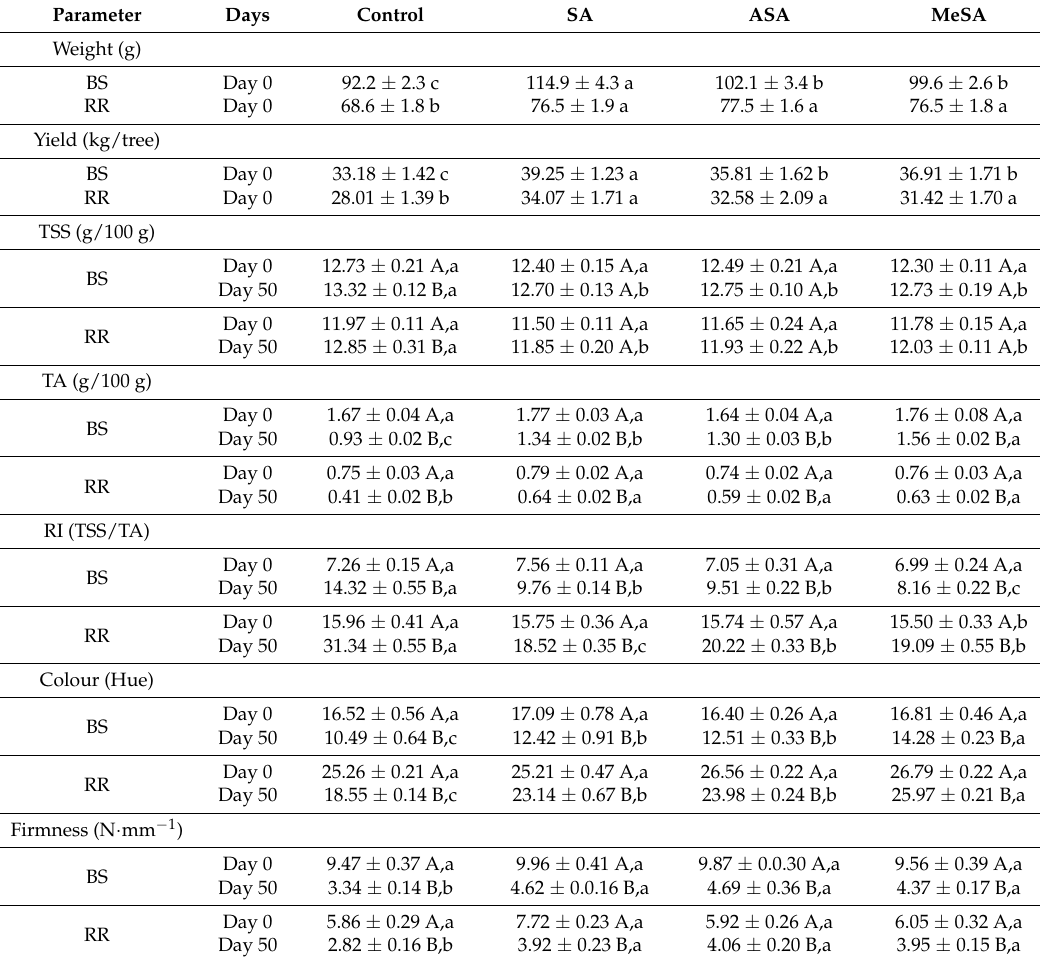
Table 1. Fruit weight, yield, and quality parameters at harvest and changes during storage (from day 0 to day 50) for total soluble solids (TSS), total acidity (TA), ripening index (RI) and colour (hue angle) in “Black Splendor” (BS) and “Royal Rosa” (RR) plums from control and salicylic acid (SA, 0.5